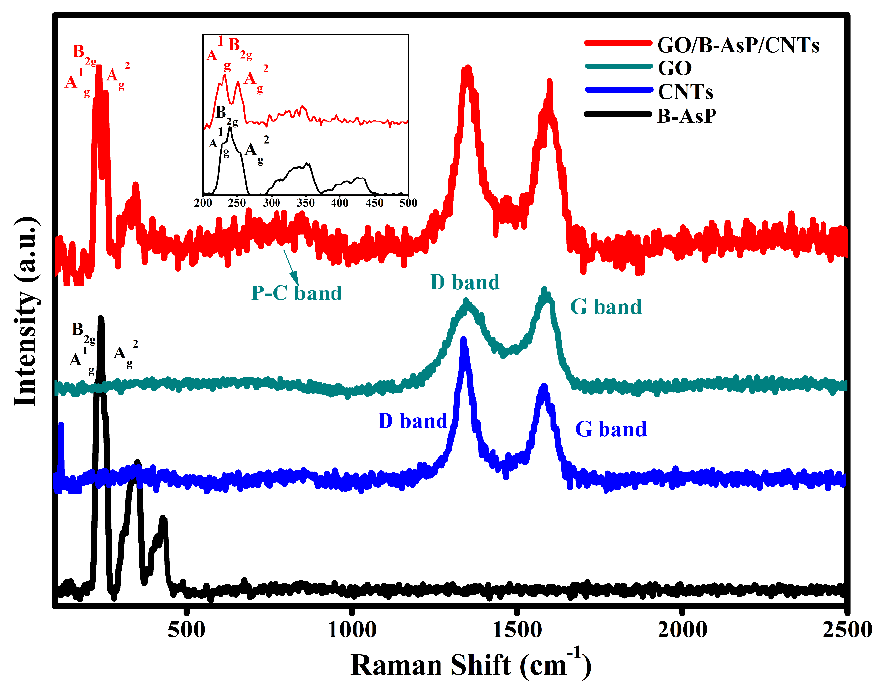
Figure 2. Raman patterns of B-AsP, CNTs, GO, and GO/B-AsP/CNTs. To further analyze the functional groups in the GO/B-AsP/CNTs composite, the XPS patterns of the GO/B-AsP/CNTs composite were measured as shown in Figure 3. As indicated in Figure 3a, in the C 1s spectra, the peak area located at binding energies of 283.5, 284.5, 286.1, 288.1, and 289.9 eV corresponded to the C-P bonds, sp 2 /sp 3 C-C, C-O bonds, and − O-C = O bonds, respectively [49]. The increased intensities corresponded to O-C = O groups. It is shown that the strength of oxygen and inner carbon atoms increases after charge–discharge cycling, and the increment in sp 3 carbon atoms is due to the adhesion of oxygen. The peak that appears at 290.7 eV in the XPS C 1s spectrum appeared due to the equipment problem. In the XPS spectrum of 2p spectra (Figure 3b), we observed double peaks representing P2p 1/2 and P2p 3/2 at 130.6 and 130 eV, respectively, which corresponded to the P-P bonds in B-AsP [50]. However, the strong peak appeared on the initial anode at 134.2 eV, which was formed by the P=O bond in P 2 O 5 , possibly by exposure to air. Except for the P–P bonds, the peak at 134.2 eV corresponded to the P-C and P-O-C bonds. The peak generated by P = O bond shifted to a lower binding energy, corresponding to P-O bond, after charge-discharge cycling. In the XPS spectrum of As (Figure 3c), we observed double peaks representing As 3d at 41.8 eV and 42.1 eV, which corresponded to the As-As bonds in B-AsP. As shown in Figure 3c, after 50 cycles, the peak of As-As bond shifts to the low binding energy because the valence state of As changes and the As-As bond shrinks during the charging-discharging process. However, the peak appeared on the initial anode at 45.5 eV, which was formed by the As-O bond in arsenic oxide, may be formed by exposure to air. The As-O bond shifted to a lower binding energy after discharge. The change of the binding state of arsenic oxide is due to the reaction of Li ions and/or deposited Li metal with oxygen atoms on arsenic particles during the charging and discharging process, resulting in the change of the oxidation state of arsenic oxide, in which arsenic oxide may be between As 2 O 5 (oxidation state; 5 + ) and As 2 O 3 (oxidation state; 3 + ) [51]. The peak that appears at 47.1 eV corresponded to the As-C bonds. Thus, arsenic, phosphorus was potentially stably trapped in the inner wall of carbon nanotubes by the presence of oxygen functional groups. XPS spectra of Li 1s (Figure 3d) confirmed the peak of lithium metal at 54.3 eV. The formation of Li 3 P, LiP and Li 3 As, LiAs was not observed at Li 1s. Therefore, it suggests that reversible reactions occur between Li + and GO/B-AsP/CNTs anode during charge–discharge cycling. The oxidation reaction of oxygen-containing functional